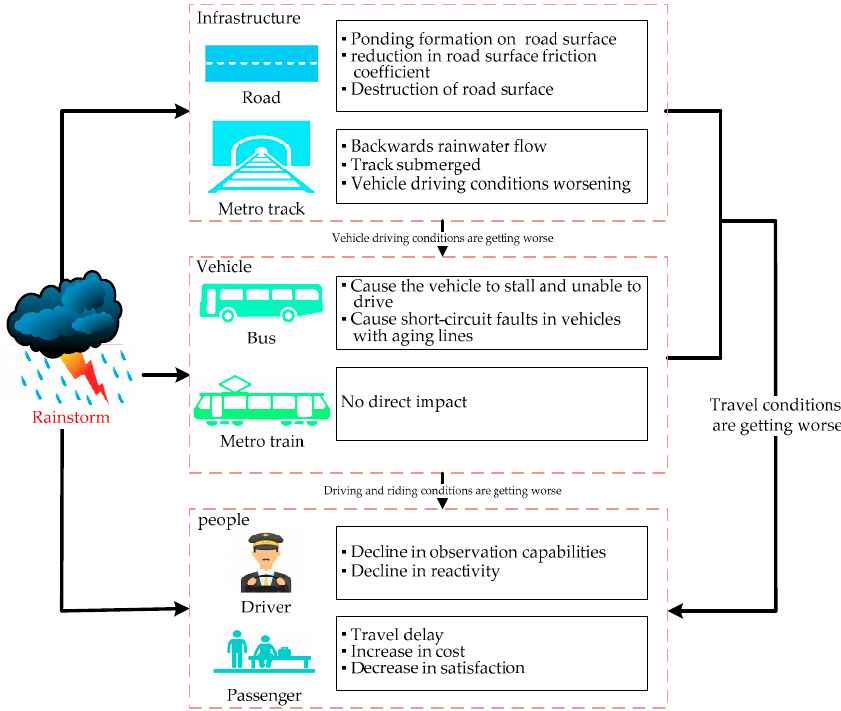
Figure 1. The influence of rainstorms on the Bus–Metro CBN .